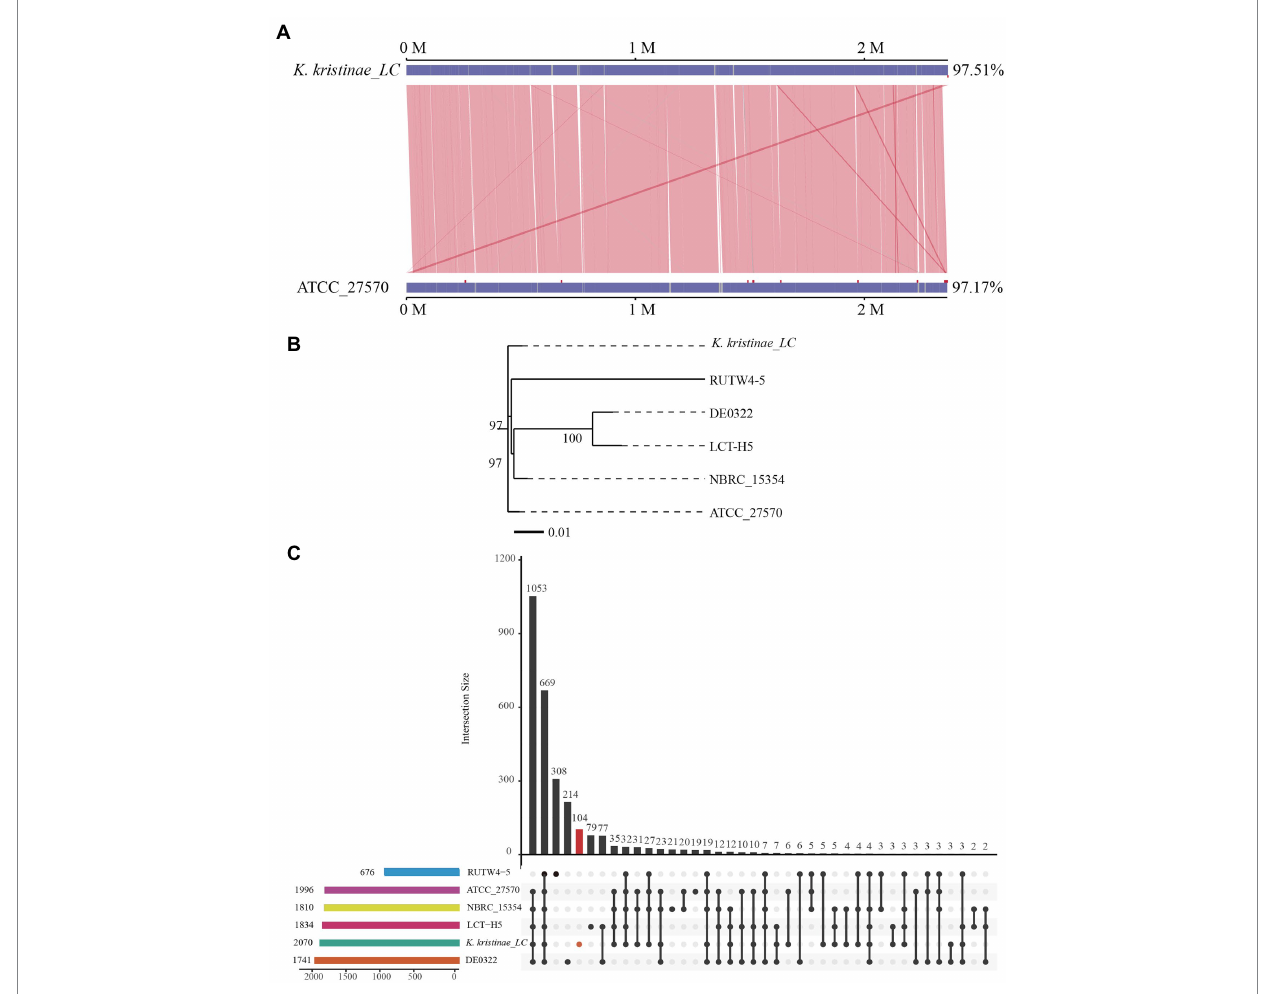
FIGURE 5 Comparative analysis of K. kristinae_LC with other strains. (A) Linearity analysis of K. kristinae_LC and ATCC_27570. (B) A phylogenetic evolutionary tree was constructed for K. kristinae_LC and other strains from different animals or origins. (C) Pangenome analysis of K. kristinae_LC with other isolates from different hosts for homology gene and distinct gene